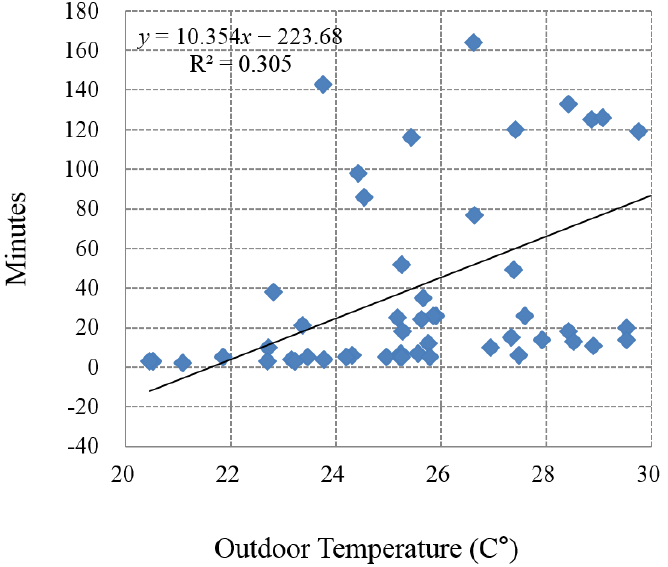
Figure 11. Relationship between the outdoor temperature ( TEMP OUT ) and the required minutes for restoring from the current temperature to the normal set-point temperature. Table 7. ANOVA test result for prediction models between inputs and output variables. Independent